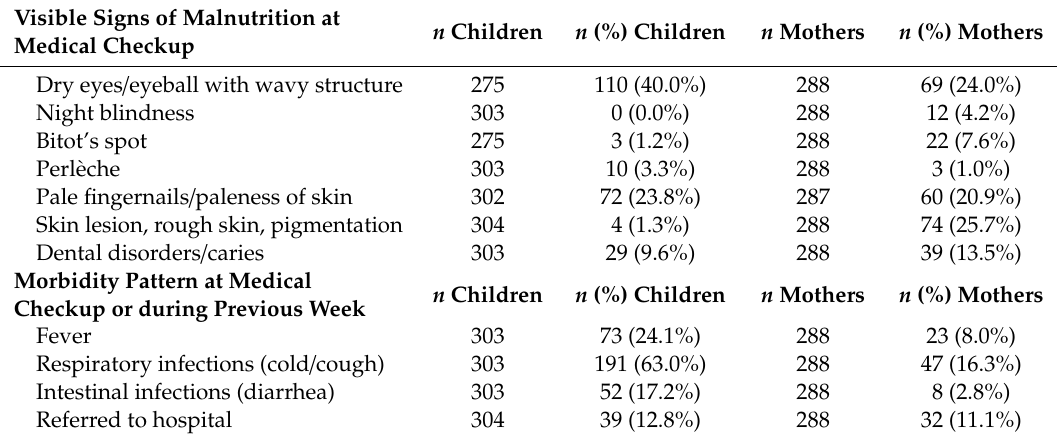
Table 8. Morbidity pattern of children and visible signs of malnutrition in mothers and children at baseline medical checkup.